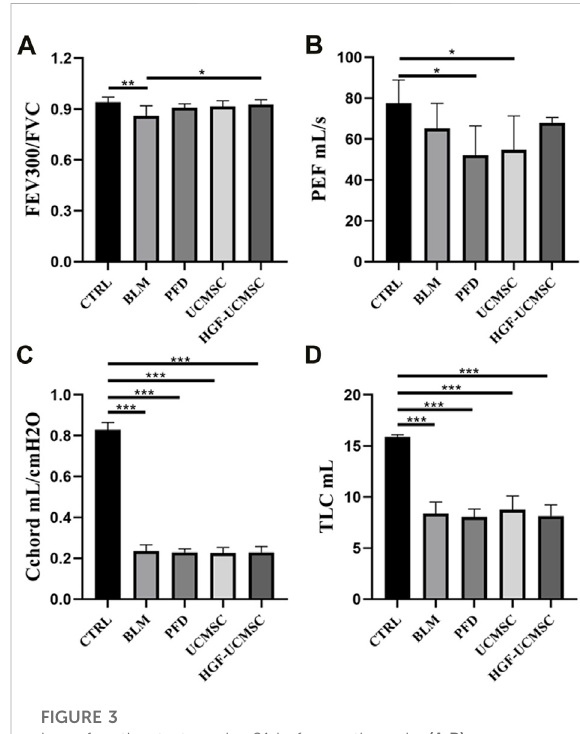
FIGURE 3 Lung function test on day 21 before euthanasia. (A,B) Pulmonary ventilatory function: forced expiratory volume in the fi rst 300 m/forced vital capacity (FEV300/FVC); peak expiratory fl ow (PEF). (C) Pulmonary compliance: chord compliance (Cchord). (D) Pulmonary volume: total lung capacity (TLC). Values arepresentedinmean±standarddeviation.* p < 0.05;** p < 0.01; *** p <